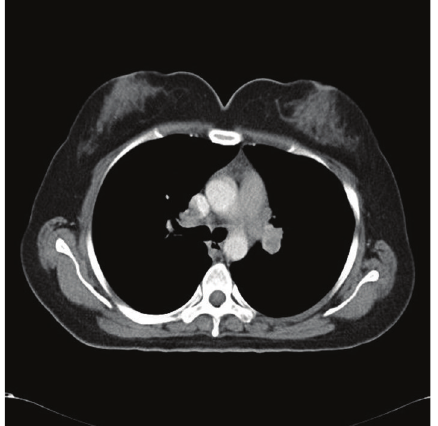
Figure 2: Bilateral hilar lymphadenopathy on thoracic CT.